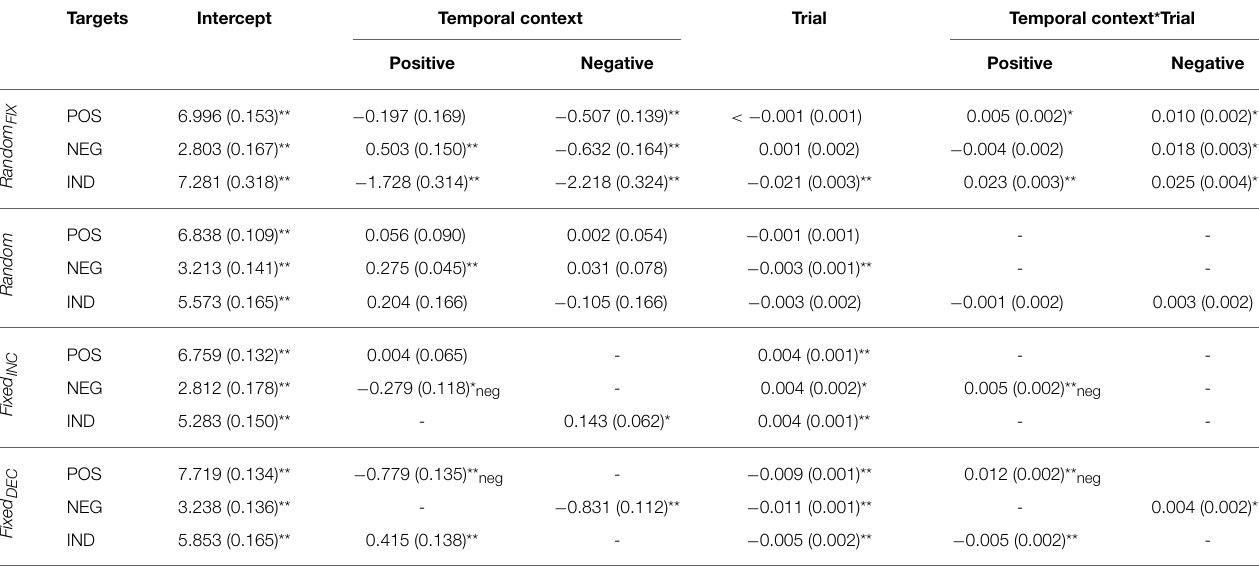
Tables 1 - 4 . Parameter estimates for each category of target image according to its temporal context. For sequences with all possible context-target combinations (i.e., Random FIX and Random), an indifferent temporal context was used as a reference—Intercept and Trial columns present, respectively, the absolute intercept and slope for each target category when preceded by an indifferent image; and the Temporal Context and Temporal context*Trial columns present, respectively, the relative change in the intercept and slope estimates when the target category is preceded by a positive or negative image. For sequences in which certain context-target combinations were not possible (see text for details), targets preceded by negative images serve as the reference. The latter comparisons are indicated by neg . Note: Values present means ( ± standard errors); ** p < 0.01; * p < 0.05.